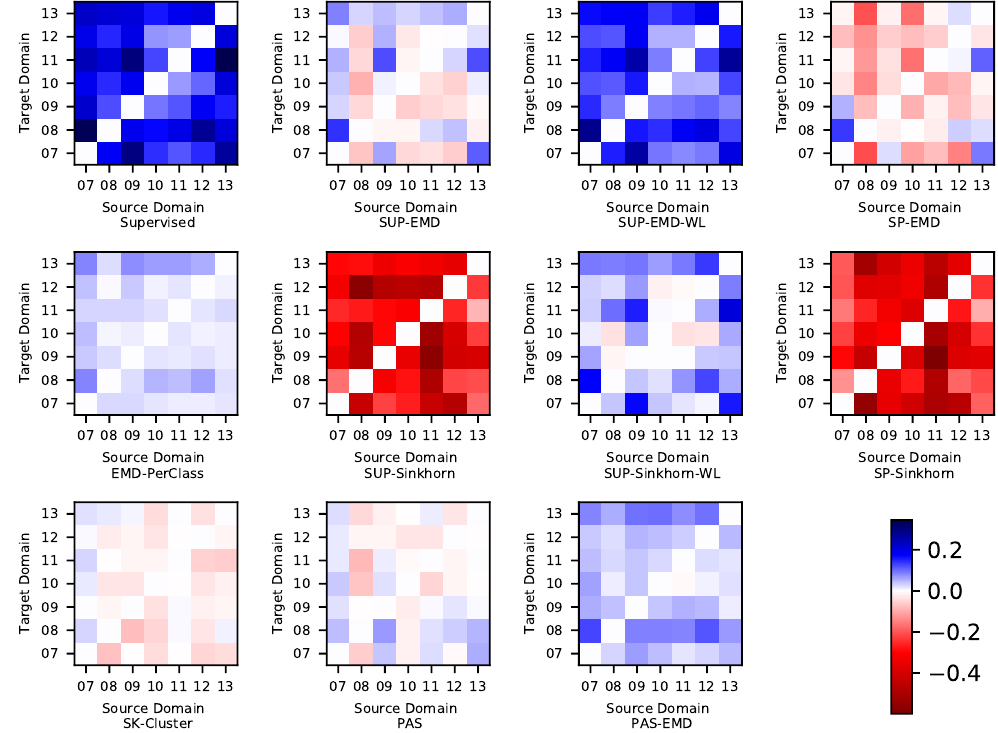
Figure 5. OA difference between the method on the x-label and the naive classification method. The color bar indicates the OA difference value. A red hue means the OA decreases using these methods, a blue hue indicates an increase. The x-axis represents the source domain. The y-axis represents the target domain. The diagonal values are set to zero as these cases only exist for supervised